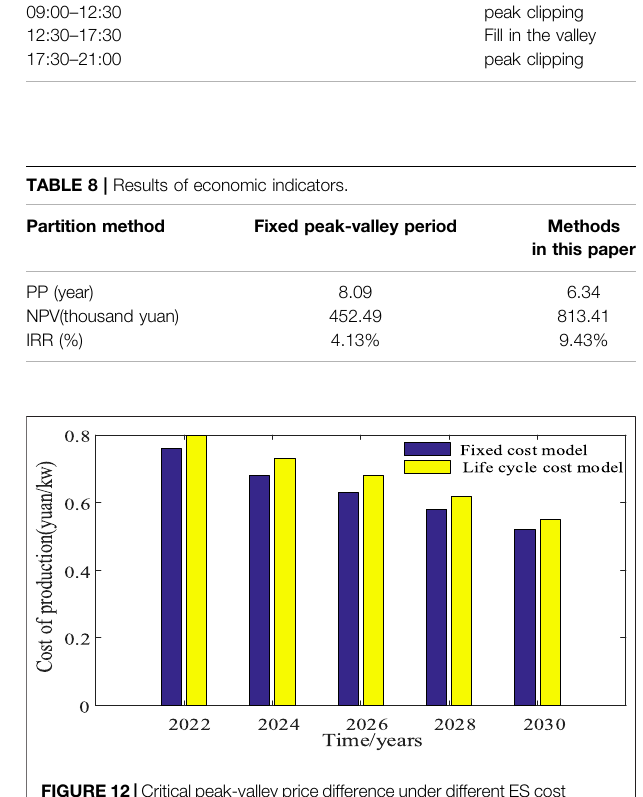
FIGURE 12 | Critical peak-valley price difference under different ES cost